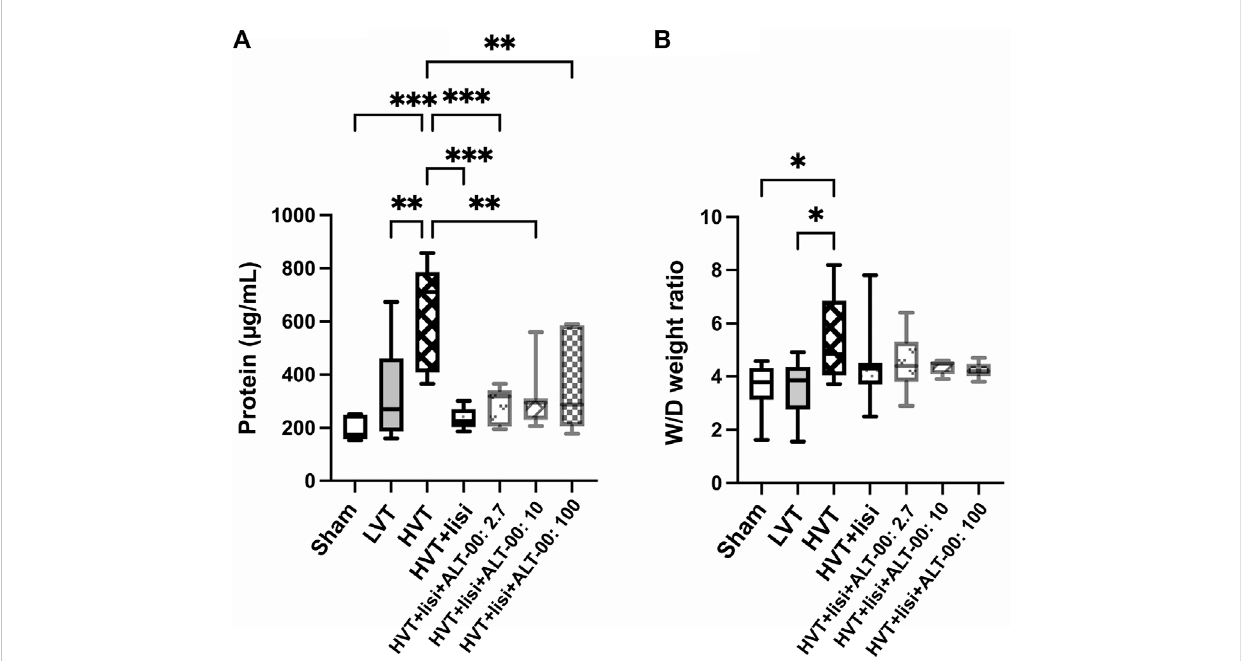
FIGURE 3 Assessmentofpulmonaryedema. (A) Theproteincontentinthebronchoalveolarlavage fl uid(BALF)wassigni fi cantlyelevatedafterhightidalvolume (HVT) ventilation versus sham and low tidal volume (LVT) ventilation. Treatment with lisinopril (lisi) ± ALT-00 reduced the protein content versus the HVT group. (B) The lung wet-to-dry (W/D) weightratio of the HVT group was increased versus the sham and LVT groups, while it was slightly reduced by lisi ± ALT-00 versus HVT controls. n = 7/group, *** p < 0.001, ** p < 0.01, * p < 0.05, compared by one-way analysis of variance with Tukey